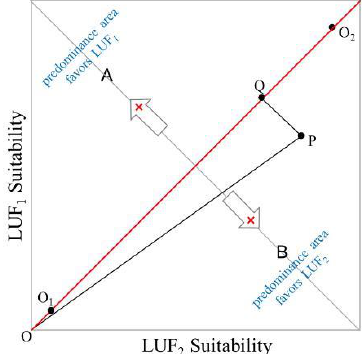
Figure 3. Land-use function conflict identification between specifical LUFs.